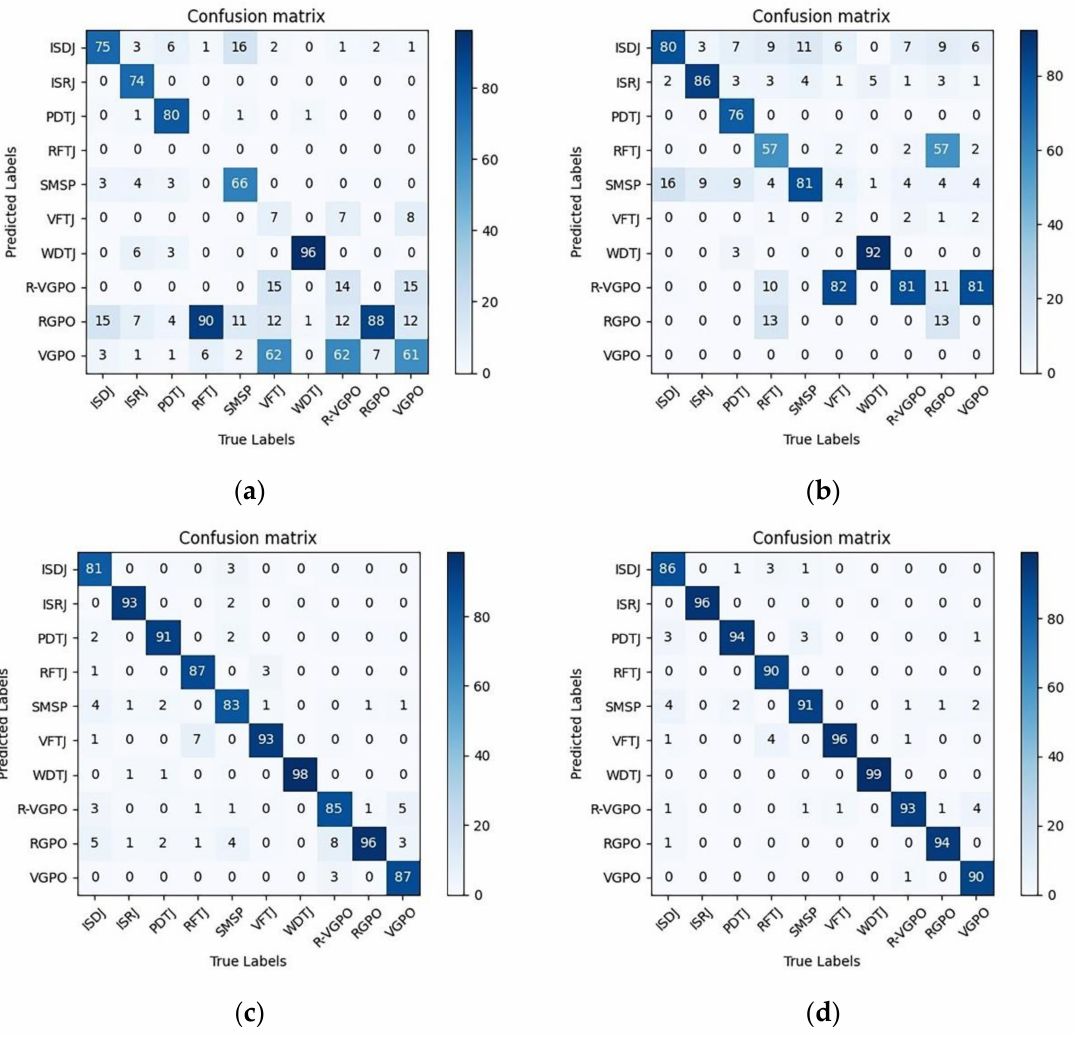
Figure 9. Confusion matrix of the four methods. ( a ) Only jamming signal. ( b ) Jamming plus echo. ( c ) Multi-pulse jamming plus echo fusion. ( d ) Multi-pulse jamming plus original signal